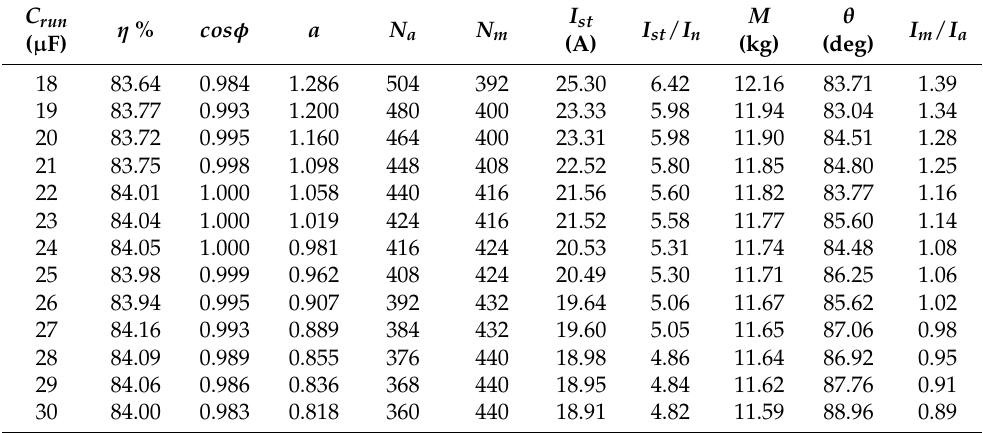
Table 9. Design parameters and performance quantities of the SPIMs with rotor bars of rectangular shape.